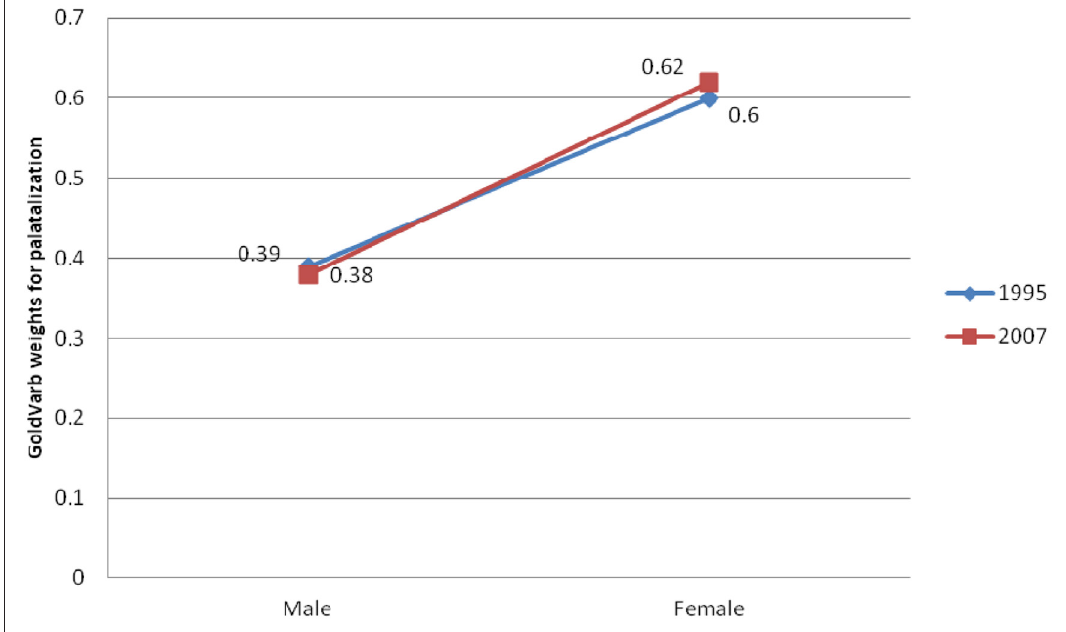
Figure 6: Comparison of rates of palatalization of dental stops followed by /i/ according to gender in